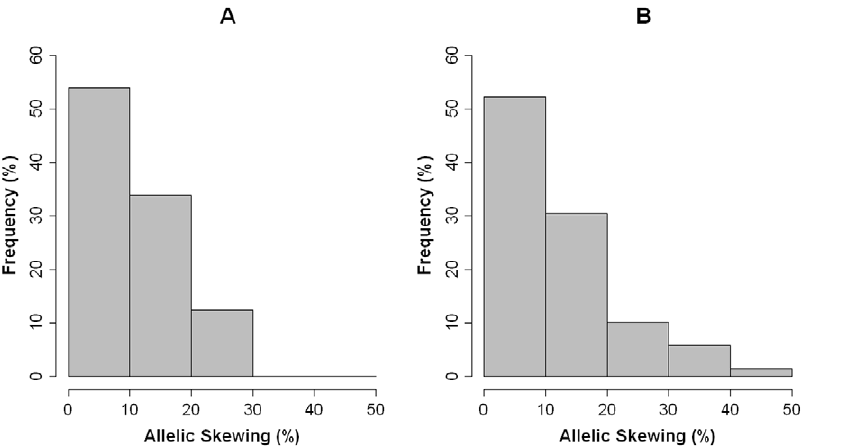
Figure 1. Allelic skewing of female children at ages 5 and 10 years as ascertained by the HUMARA assay performed in triplicate. Allelic skewing of female children at ( A ) age 5 and ( B ) age 10. Allelic skewing is defined as the percentage deviation from the presumed ‘normal’ 50:50 XCI patterns and is assigned to 5 ‘‘bins’’ representing increments of 10%. More instances of extreme allelic XCI skewing are observed at age 10 than age 5. XCI=X-Chromosome Inactivation . doi:10.1371/journal.pone.0017873.g001 PLoS ONE |